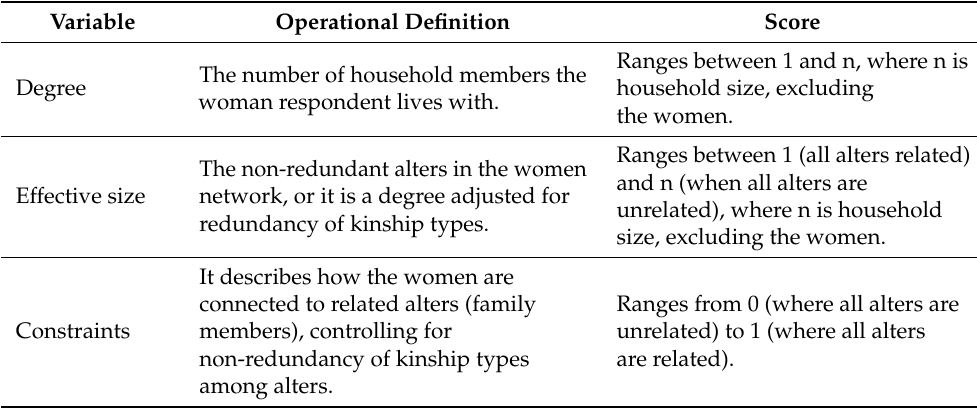
Table 1. Summary of scoring of structural